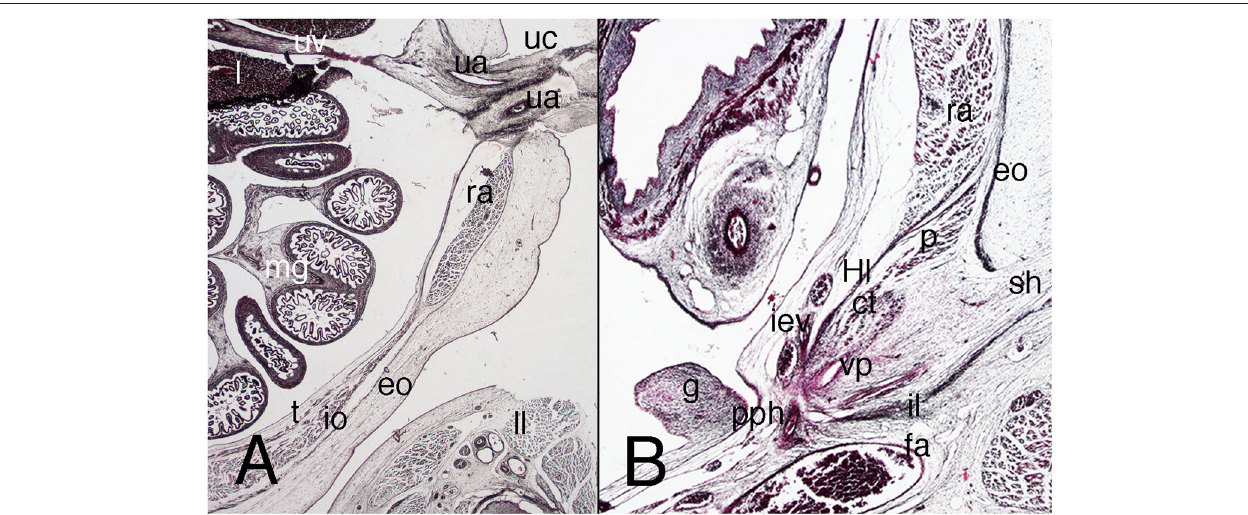
FIGURE 9 | Sagittal sections of the abdomen in a female fetus F-25 (10th week). Azan staining. (A) (1X) at the umbilical and infra-umbilical regions; (B) (2X) section of the inguinal region. ct, common tendon; eo, external oblique muscle; fa, femoral artery; g, gonad; iev, inferior epigastric vessels; io, internal oblique muscle; Hl, Hesselbach’s ligament; l, liver; mg, middle gut; p, pyramidalis muscle; pph, preperitoneal hole; ra, rectus abdominis; sh, subcutaneous hole; t, transversus muscle; ua, umbilical artery; uc, umbilical cord; uv, umbilical vein.